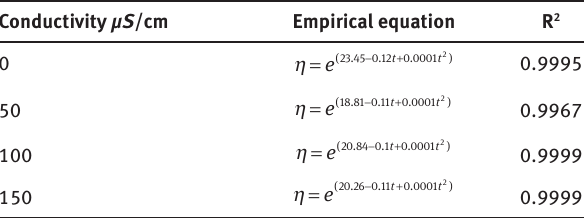
Table 3: Empirical equation for kinematic viscosity and temperature of Jatropha curcas